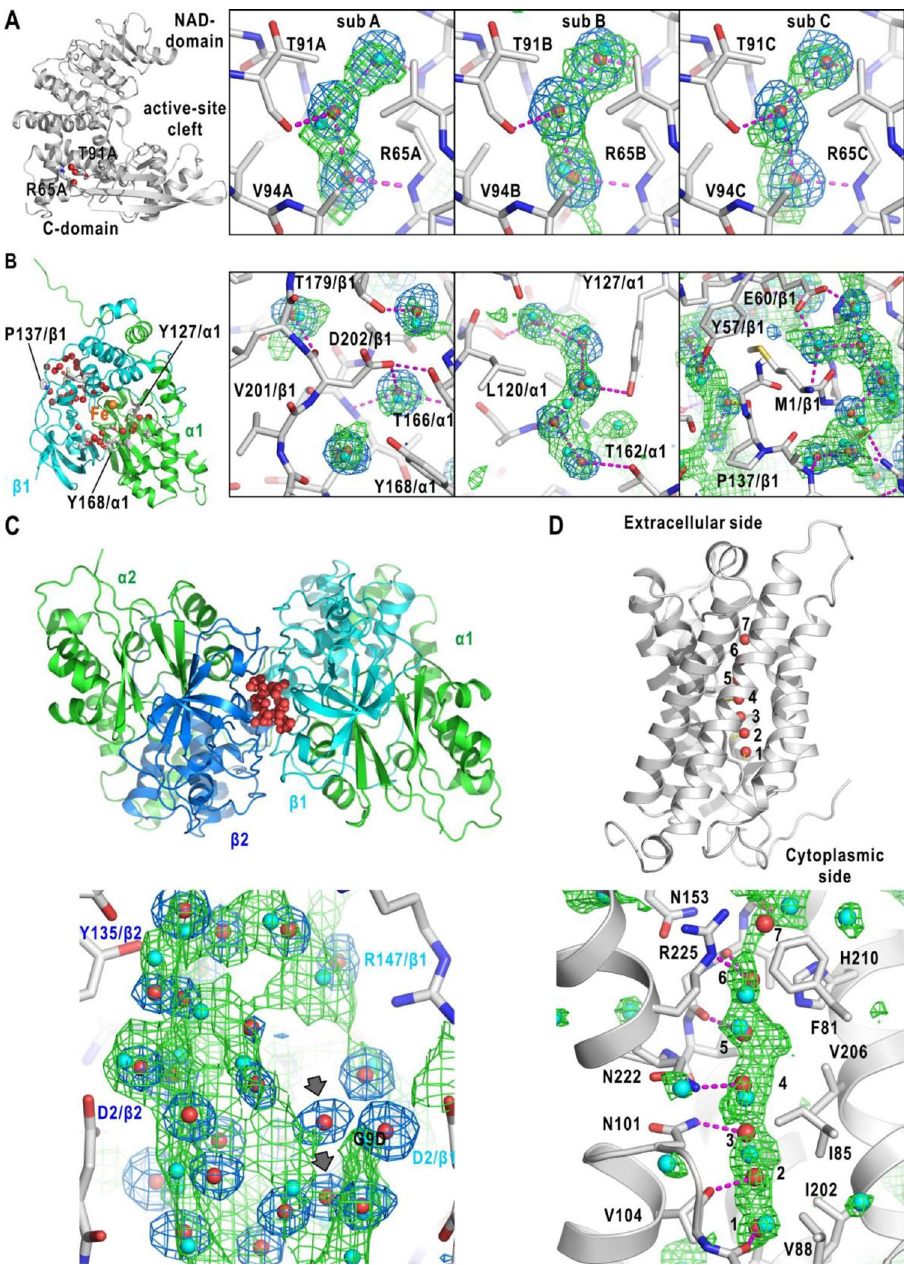
Figure 3. Prediction for cavities, interface, and channel. ( A ) Prediction for the three hydration sites in small cavities in subunits ( A ), ( B ), and ( C ) of GDH. The location of the cavity in subunit ( A ) is illustrated in the left panel. The green mesh is the probability distribution contoured at 80% probability, and the local peak positions are indicated by cyan spheres. The blue nets are the omit-difference Fourier electron density maps of crystal- water molecules (red spheres) at the highest resolution (see Table SI2) contoured at three standard deviation levels from the average. Amino acid residues forming the cavities (or channels) are shown using stick models, and the potential hydrogen bonds are indicated by magenta dashed lines. Illustrations in panels ( B )–( D ) are drawn similarly. ( B ) Predicted hydration distributions for three cavities in NHase. The locations of the cavities are shown in the left panel. ( C ) Predicted hydration probability distribution for water molecules confined in the interface between the two β-subunits of NHase (upper panel). The gray arrows indicate the hydration water molecules without direct contact with protein atoms. ( D ) Predicted hydration probability distribution in the solvent channel with seven hydration water molecules (1–7) of a subunit of tetrameric AQP (the accession code of PDB: 1z98, upper panel). Two of the channel-forming α-helices are illustrated as ribbon